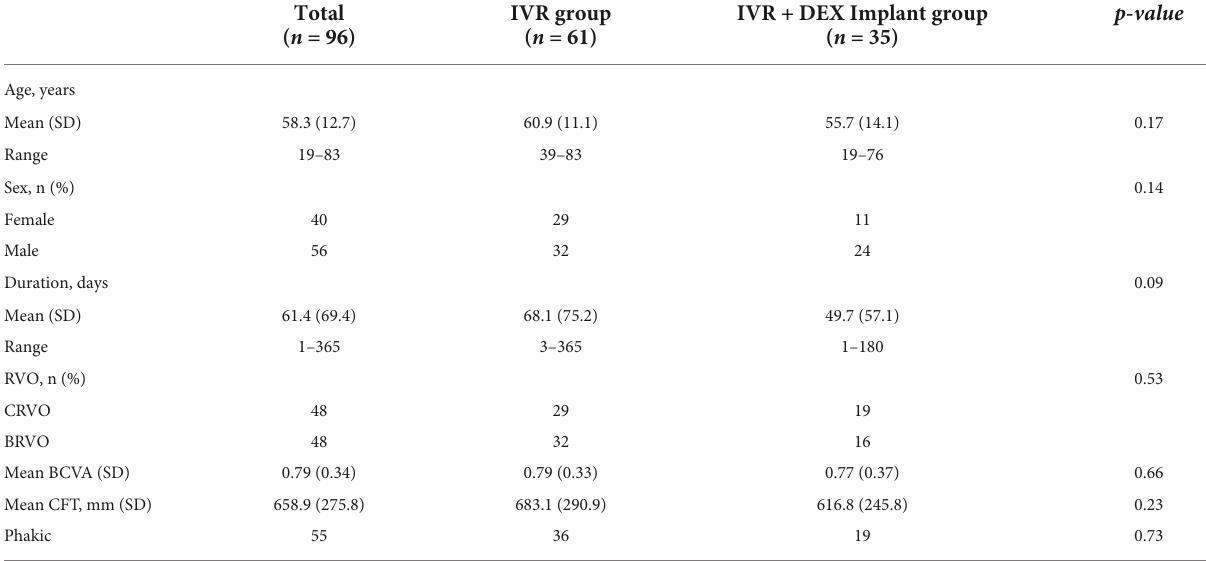
TABLE 1 Demographics and baseline characteristics.